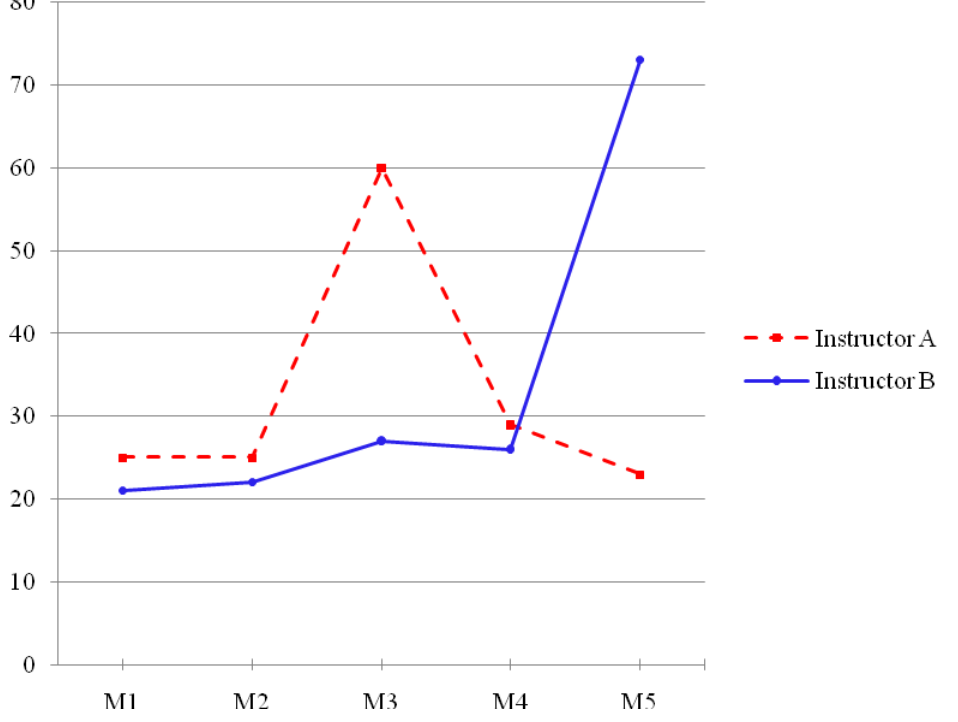
Figure 4 . Total teaching presence over